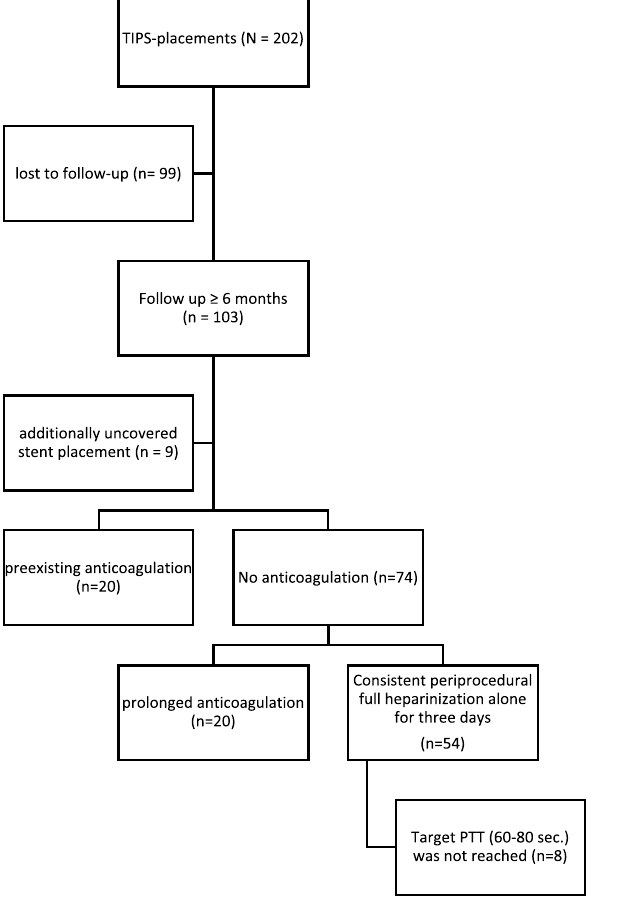
Figure 5. Flow-shard of inclusion and exclusion criteria. Search query revealed 202 new TIPS placements between 2014 and 2018. Ninety-nine patients were excluded as no post-interventional information was available (lost to follow-up). 103 TIPS placements were included in this retrospective analysis. 9 patients were excluded because of additionally uncovered stent placement. 20 patients had a preexisting anticoagulant drug and in 20 patients, the ward administered prolonged anticoagulation after the intervention. 54 patients were treated with periprocedural heparinization